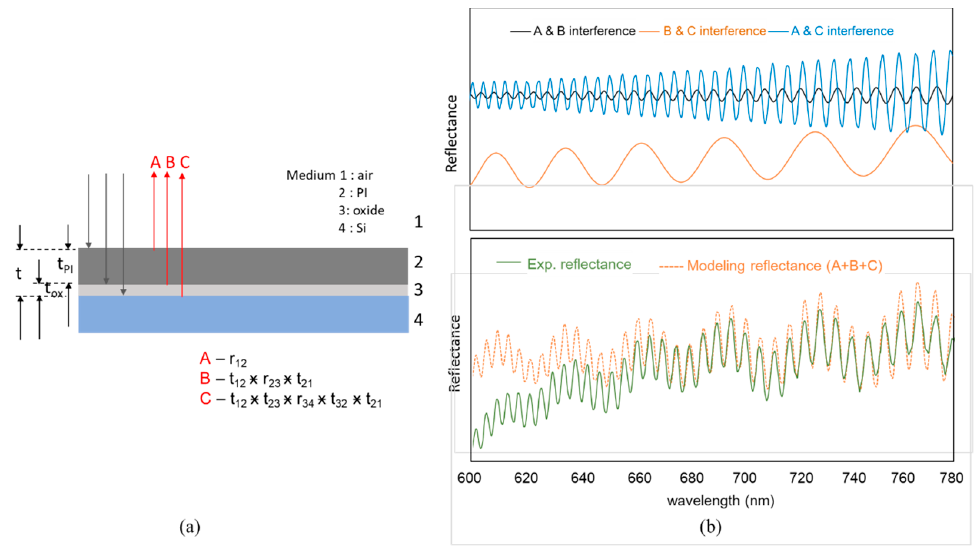
Figure 11. ( a ) Simulation model of the PI layer on the BGA sample; the silicon substrate has an insulating oxide layer above and a PI layer on top. The physical thicknesses of the PI and oxide are t PI and t ox respectively. ( b ) Top: simulation interference spectrum of each pair of reflecting lights A, B, and C. Bottom: Fitting of the combined reflectance spectrum (A + B + C) with the experimental reflectance. The fitting results were t PI = 25.34 µ m and t ox = 5.31 µ